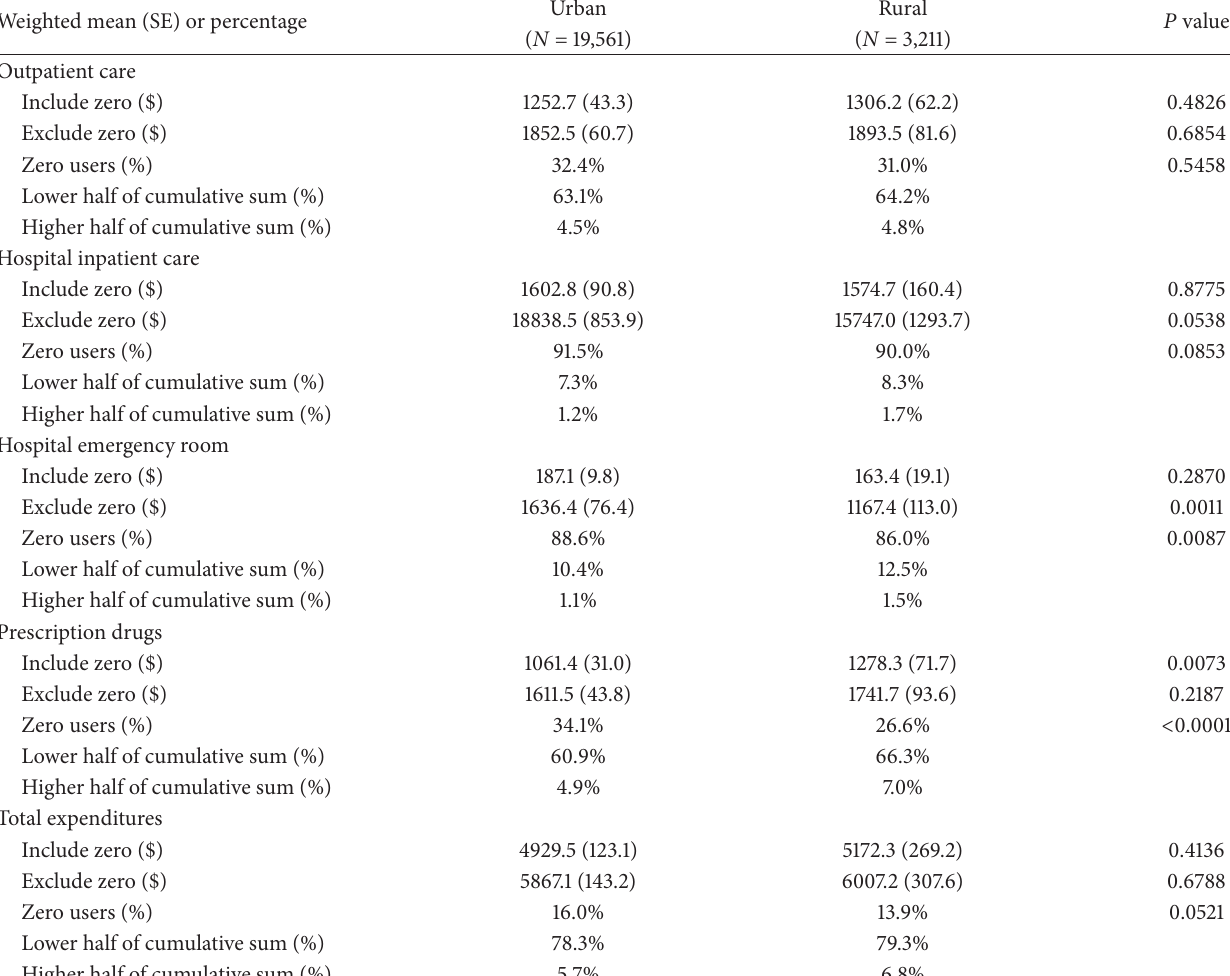
Table 1: Comparisons of weighted individual expenditure distributions by residence and type of service, MEPS